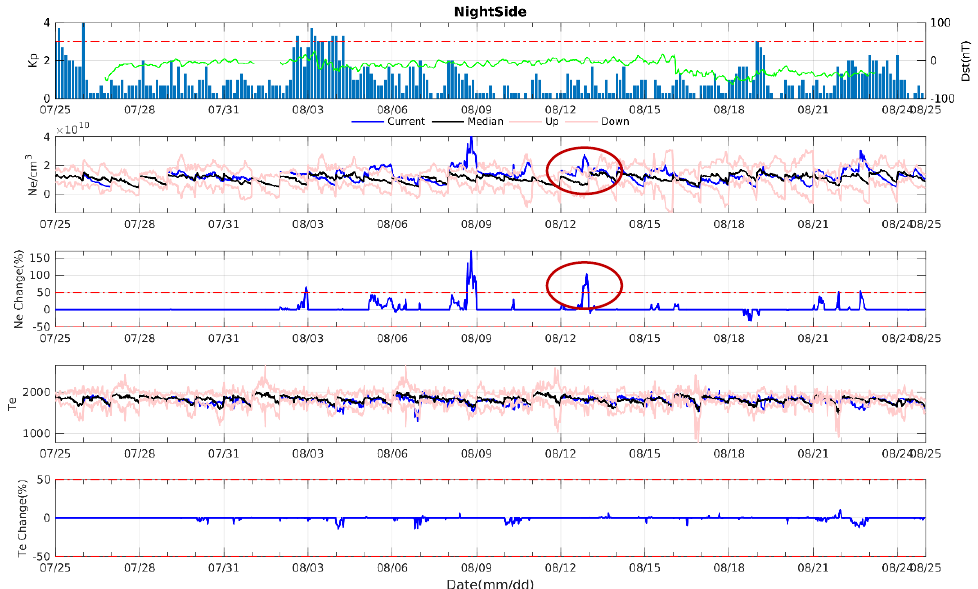
Figure 3. The electron density disturbances over the 18 August 2020, M 7.0 Sumatra EQ influential area. The space weather index Kp is presented by blue bars, and the Dst index is displayed by the cyan curve. The red horizontal dashed line represents the values of Kp =